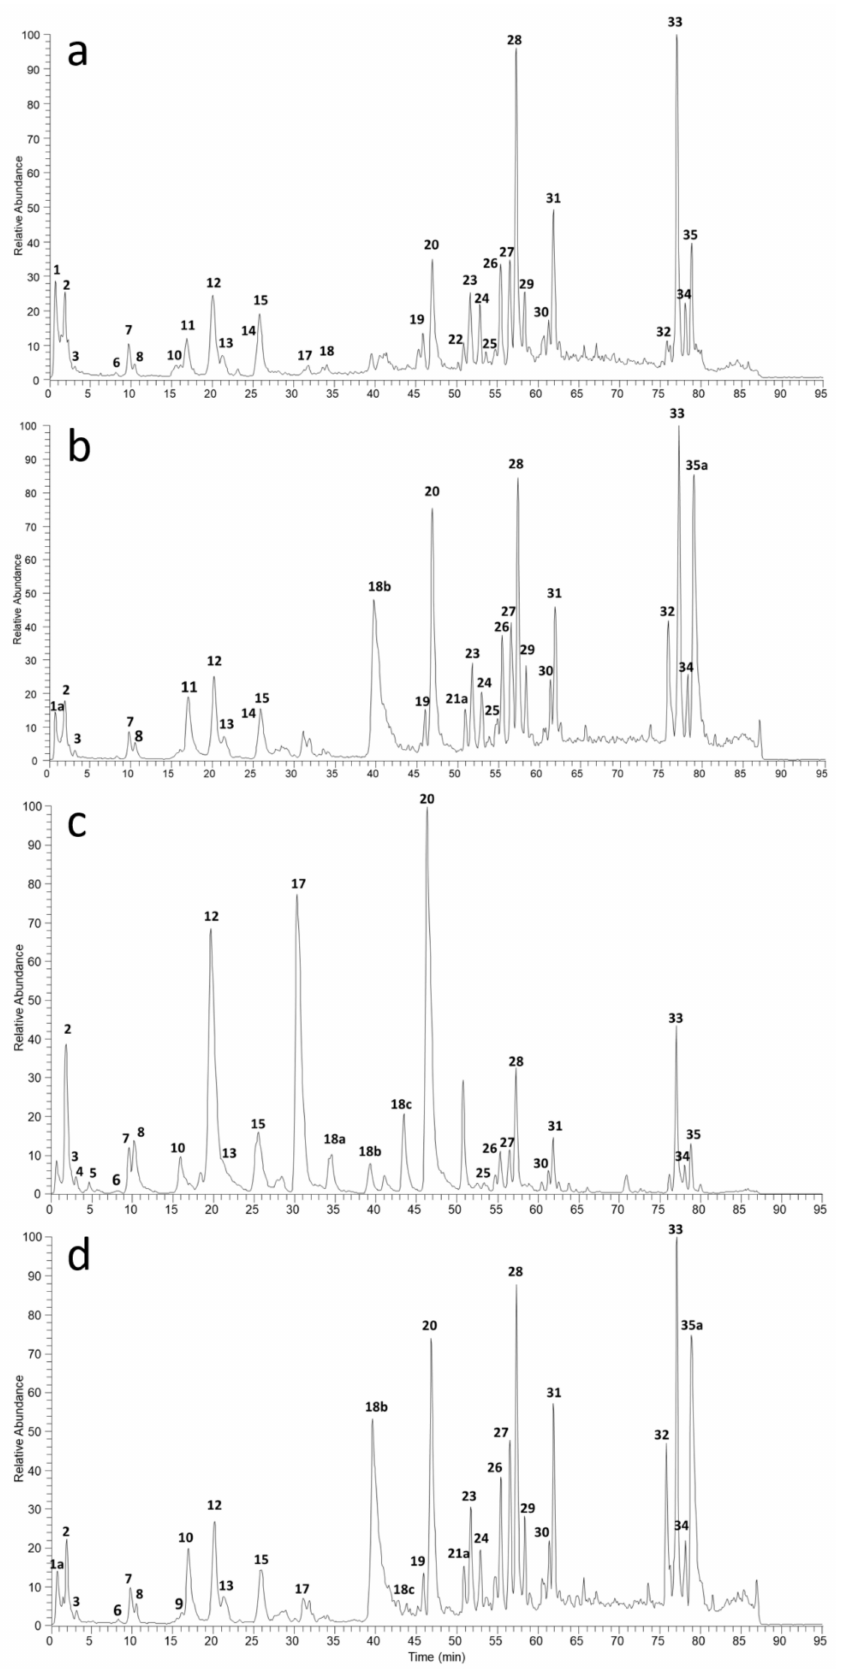
Figure 1. Total ion chromatograms (TICs, negative ion mode) of aqueous and hydro-alcoholic extracts of ripe pu-erh tea ( a – b , respectively) and raw pu-erh tea ( c – d ,